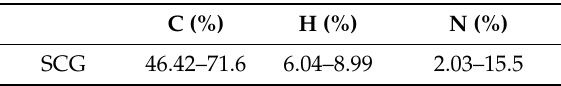
Table 2. Comparison of ultimate analysis of SCG [3].